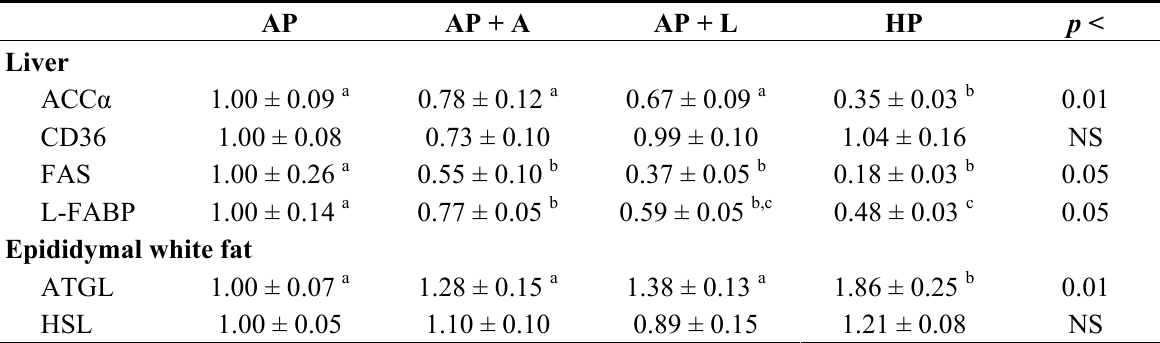
Table 1. Relative gene expression levels of liver and white adipose tissue proteins from ten weeks old male C57BL/6 mice fed different diets with an adequate (AP), a high (HP) or an adequate protein concentration supplemented with L -alanine (AP + A) or L -leucine (AP + L) for one week [19] 1,2 . AP AP + A AP + L HP p < Liver ACC α 1.00 ± 0.09 a 0.78 ± 0.12